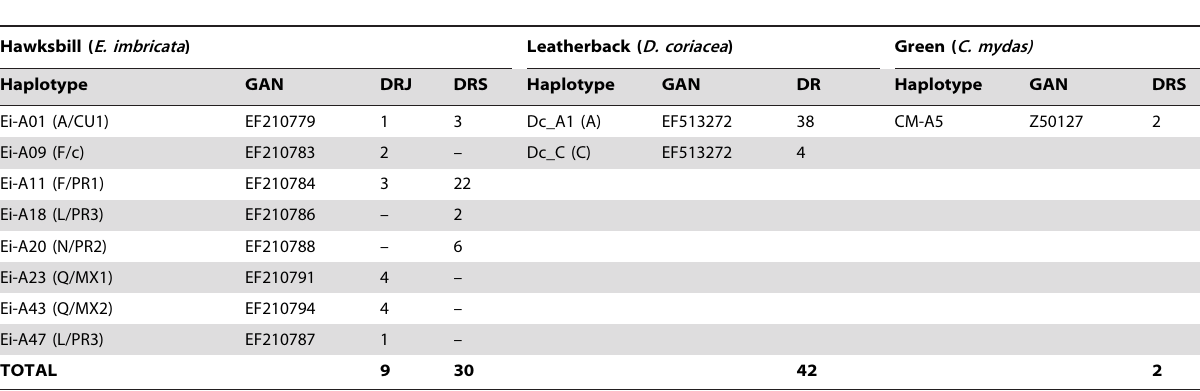
Table 1. Haplotype frequencies found in Dominican Republic marine turtle